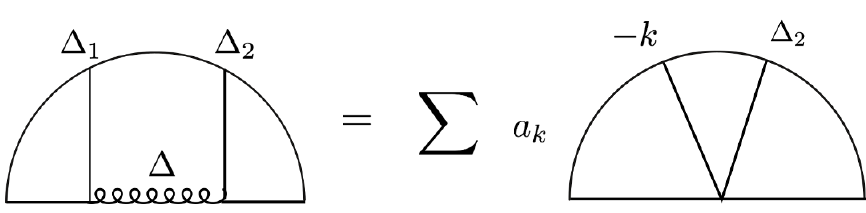
Figure 6 . The interface exchange Witten diagram is replaced by a (cid:12)nite sum of contact Witten